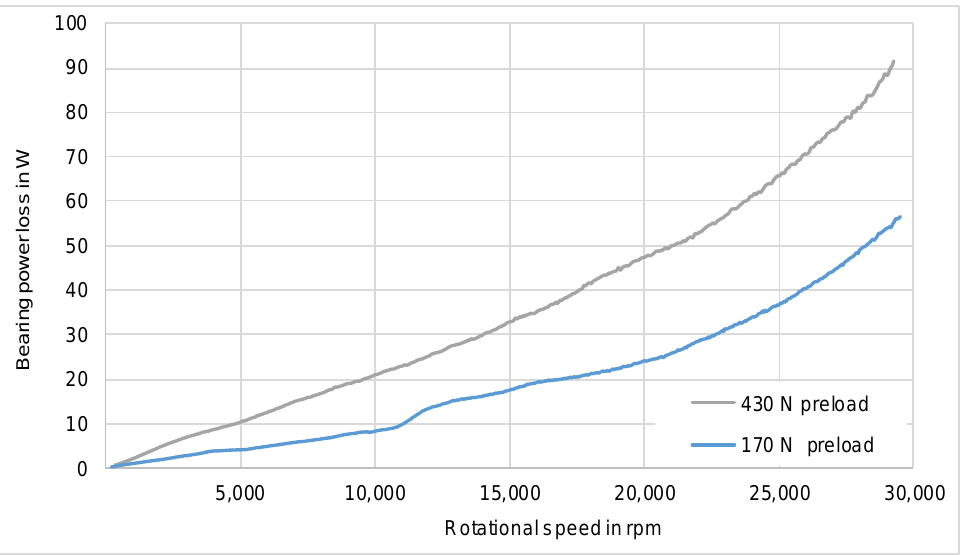
Figure 19. Bearing power loss under different axial preloads as a function of rotational speed for a system consisting of two myonic SRD 30550VA bearings and Klüberquiet BQR 78/102 grease.